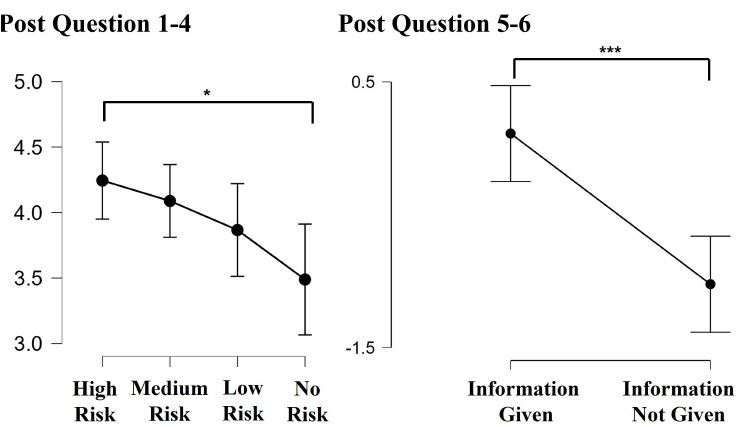
Figure 11. A graph that compares post-questionnaire data according to risk level and whether to provide information to HUD or not. The use of asterisks in the figure indicates statistical significance. A single asterisk (*) denotes a p -value less than 0.05, while three (***) asterisks denote p -values less than 0.001,